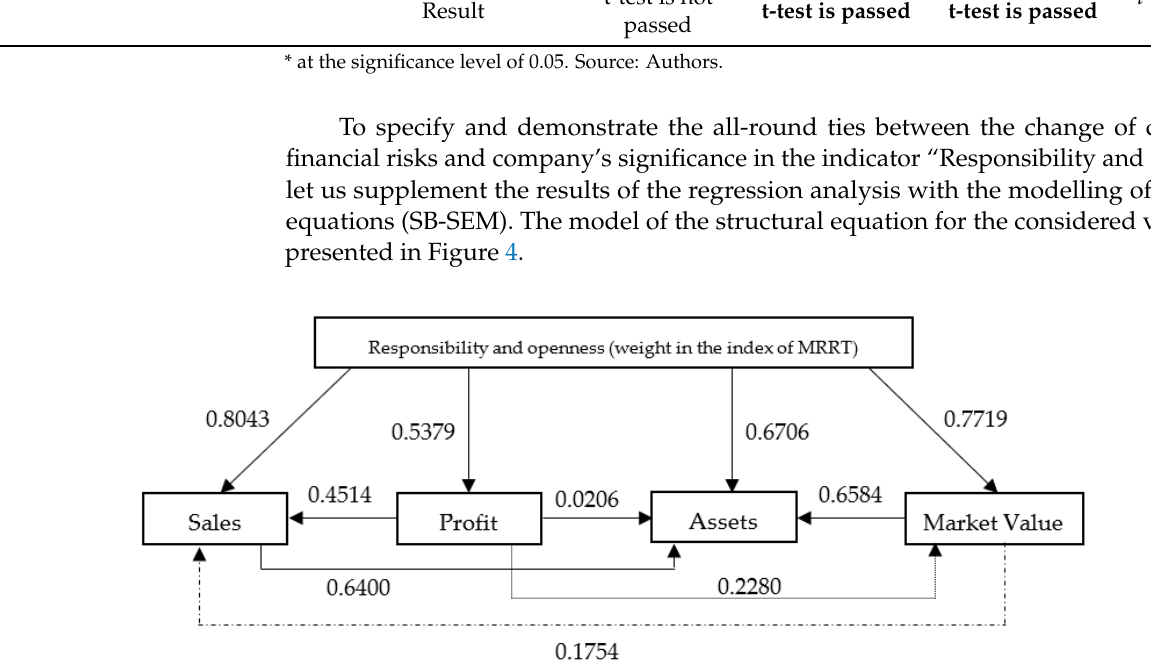
Figure 4. The model of the structural equation. Source: calculated and compiled by the authors.